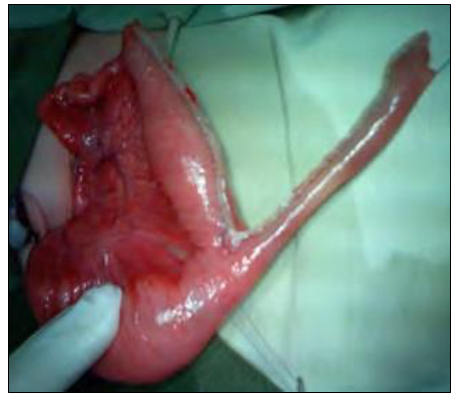
Figure 2: GIA auto stapler linear cutter is used to divide the proximal dilated portion of an intestinal atresia which divided it into V-shaped two conduits. The entire suture line is reinforced with additional layer of manual suturing with Vicryl/PDS 5/0. We always reinforce the suture line with interrupted 5 zero Vicryl/PDS on a round body needle. Special